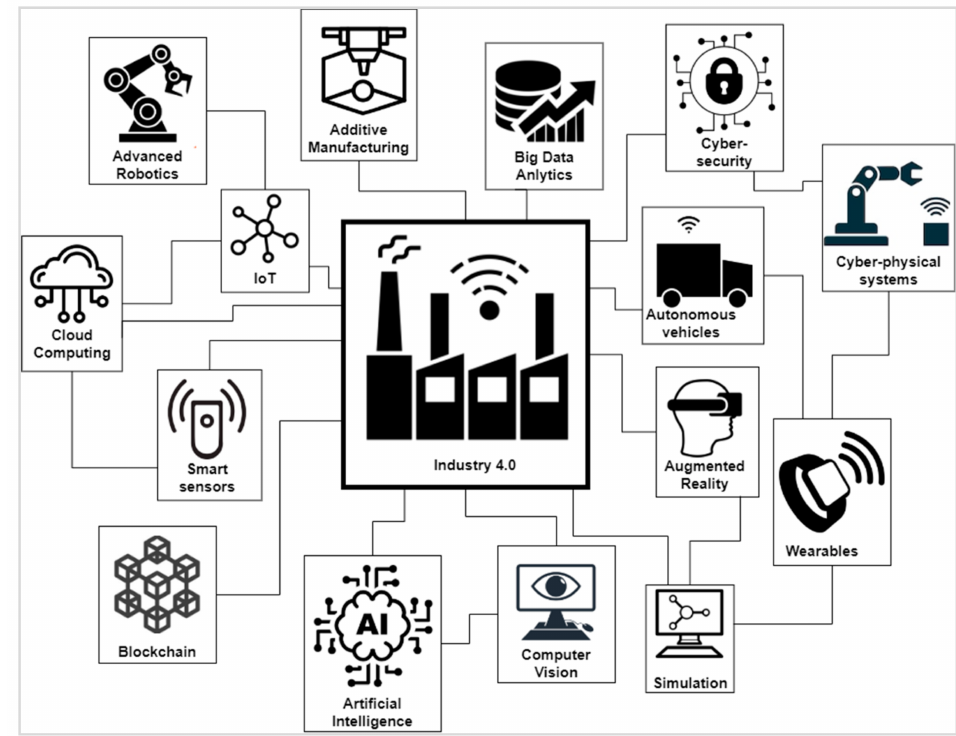
Figure 2. Key components of Industry